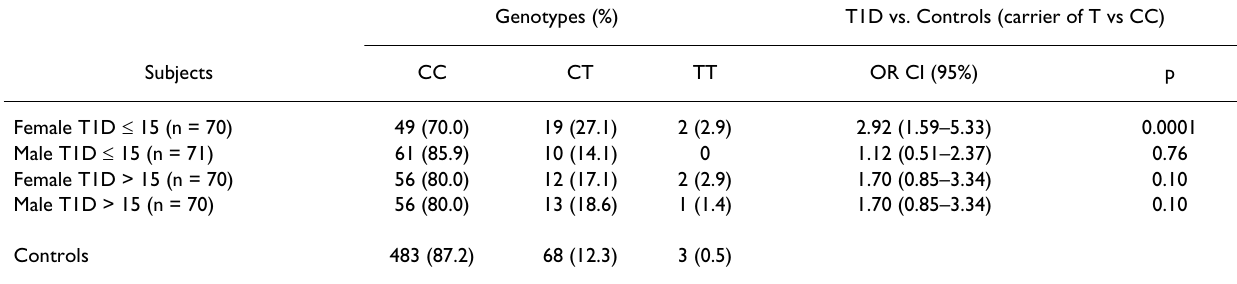
Table 2: Gender and age distribution of the PTPN22 C1858T polymorphism in Spanish T1D patients Genotypes (%)